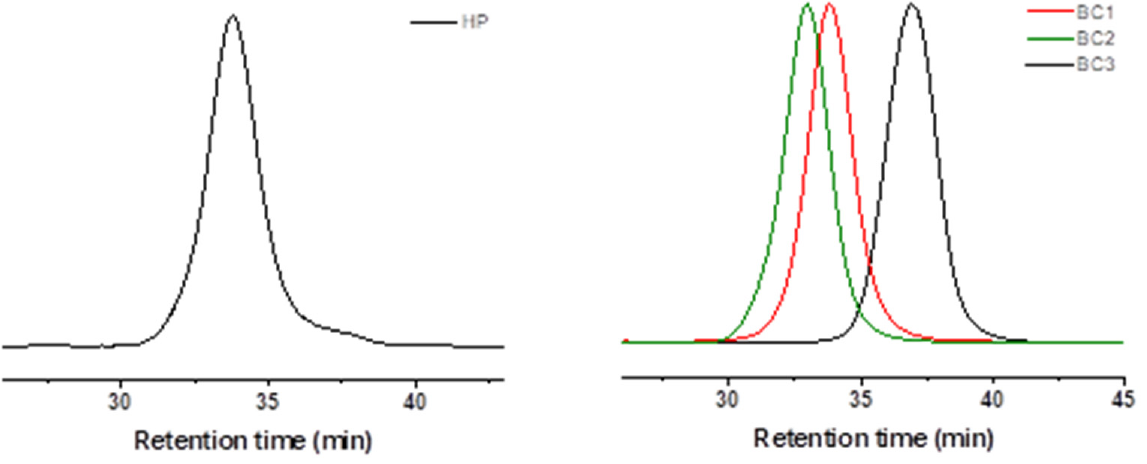
Figure 2. SEC chromatograms of the PTEGMA ( left ) and PLA- b -PTEGMA diblock copolymers ( right ) in chloroform–triethylamine–isopropanol (94/4/2 vol%).